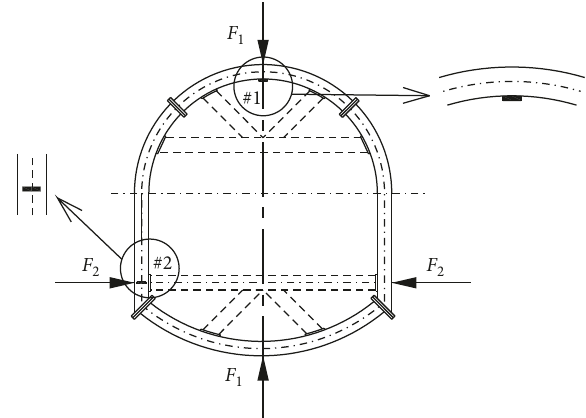
Figure 4: Strain gauges on the scaled